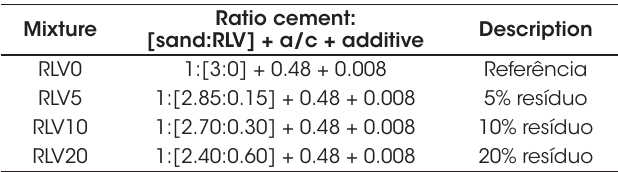
Definition of the ratios for the composites